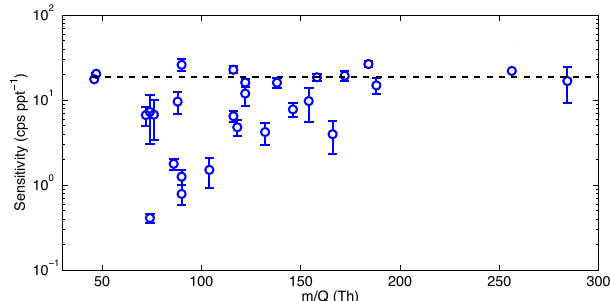
Figure 1. The distribution of observed sensitivities to carboxylic acids using acetate reagent ions. Error bars are 1 σ based on multi- ple injections of solutions following Mohr et al. (2013). The black dashed line shows the sensitivity value used for bulk